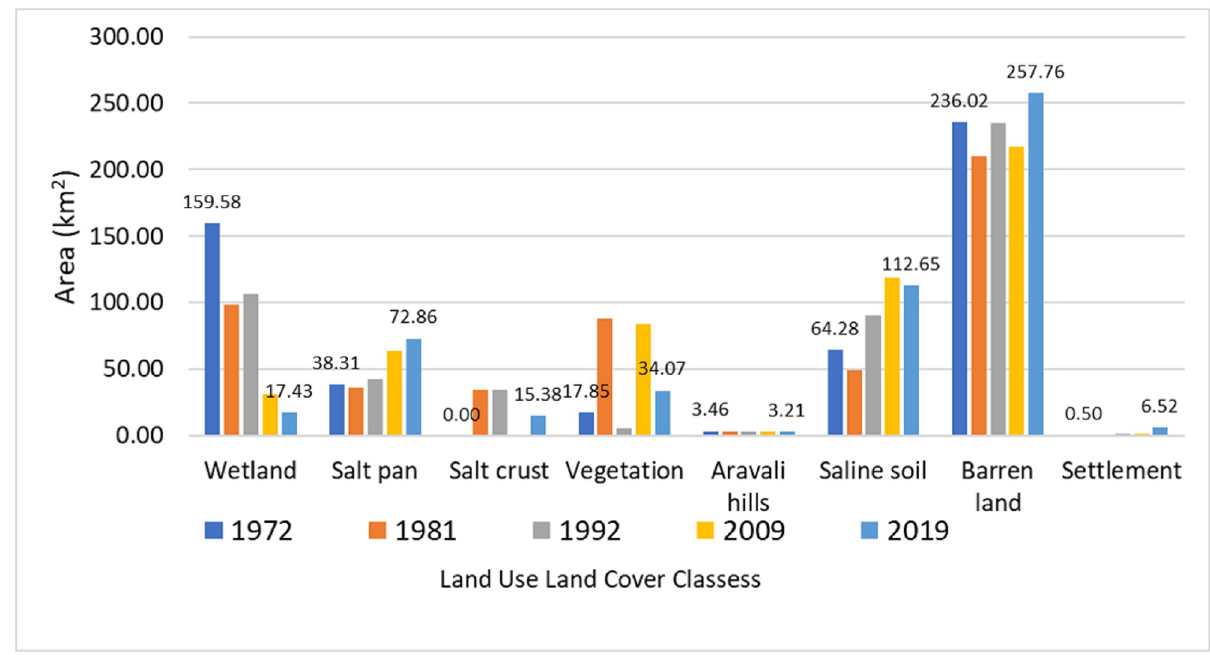
only vegetation changed negatively; the rest of the classes like increased wetland by 0.73%, salt pan by 1.68%, salt crust by 0.08%, Aravali hills by 0.06%, saline soil by 7.71%, and barren land by 1.11% and settlement by 0.43%. From 1992 to 2009, wetland decreased by -4.14% followed by salt crust by 5.88%, Aravali hills by 0.11%, and barren land by 0.45% whereas vegetation by 0.20%, and saline soil by 1.78% positive K. From 2009 to 2019, wetland, vegetation, Aravali hills, salt crust, and saline soil showed negative K by 4.47%, 5.95%, 0.11%, 0.00%, and 0.48% respectively and salt pan, barren land, and settlement showed positive K of 1.36%, 1.86%, and 37.98% respectively. The settlement has high K value in this decade. LULC transition matrix (Table 4) states conversion from wetland (75 km 2 ) to saline soil, second largest from barren land to (22.5 km 2 ) to vegetation. 0.96 km 2 of Aravali hills to barren land, saline soil (21.67 km 2 ) to barren land. 13.87 km 2 and 12.11 km 2 of salt crust are to saline soil and barren land respectively.